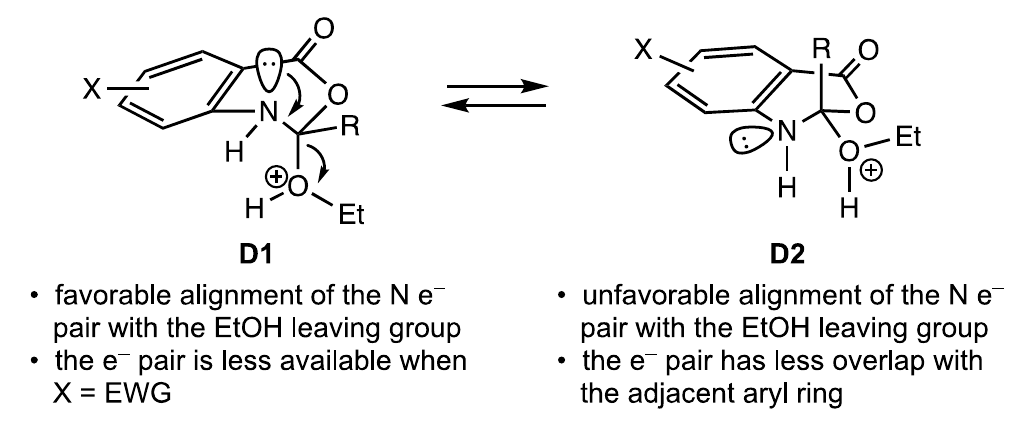
Figure 2. Conformational options for intermediate D .